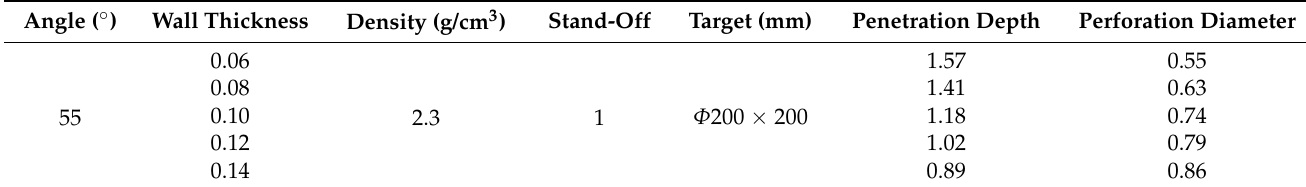
Table 3. Experimental results for reactive liners with different wall thicknesses (CD). Angle ( ◦ ) Wall Thickness Density (g/cm 3 ) Stand-Off Target